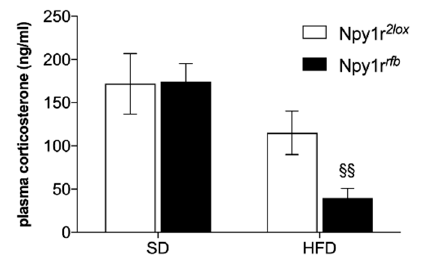
Figure 5. Corticosterone levels. Npy1r rfb mice on HFD showed a significant reduction of corticos- terone plasma levels compared to the SD-fed group. Values are presented as mean ± SEM. §§ p < 0.01 versus Npy1r rfb on SD.